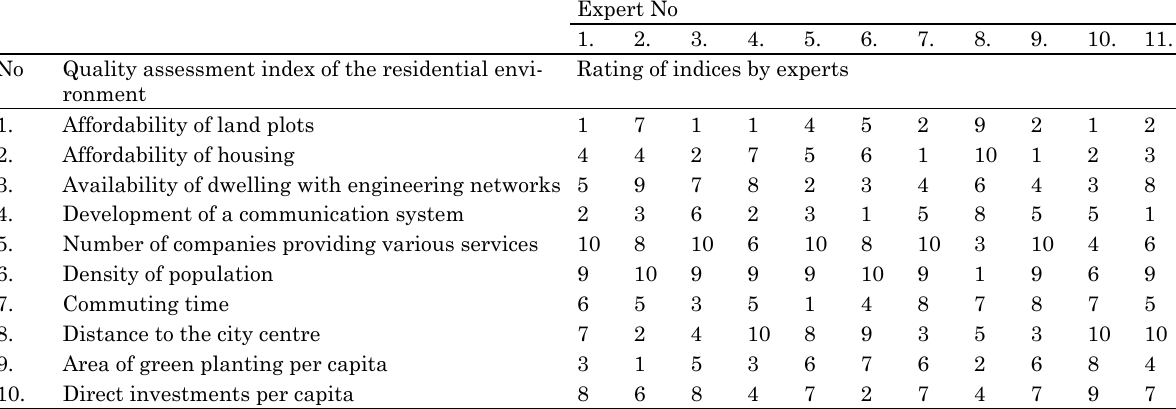
Table 1. Subjective rating by experts of the residential environment indices in 2013